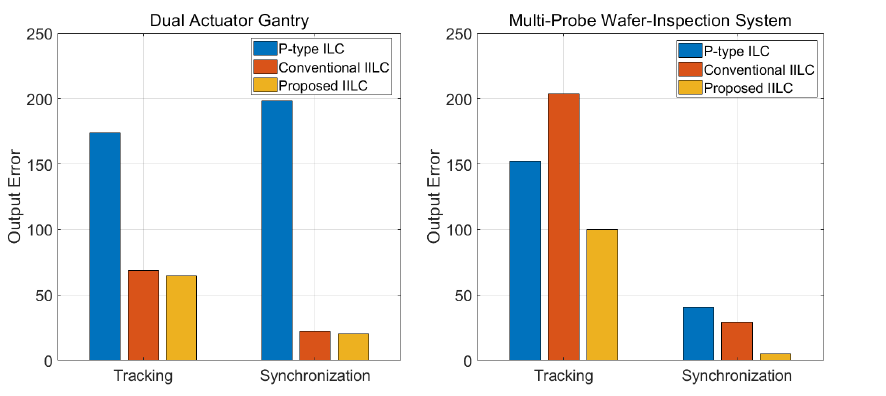
Figure 15. Comparison for tracking and synchronization error in each